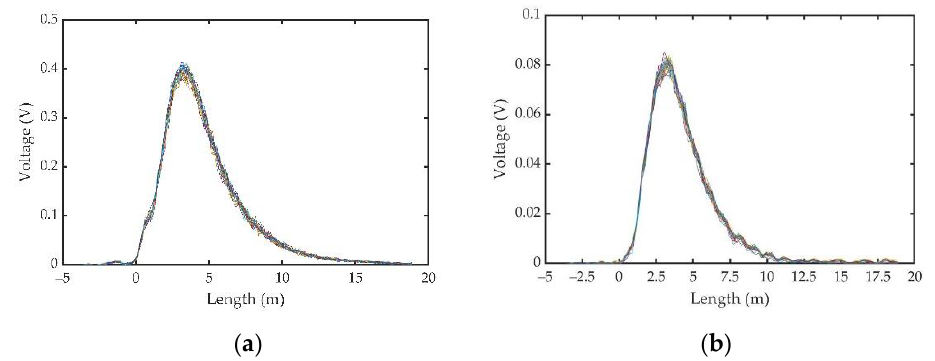
Figure 9. Scattered signals before and after passing through an iodine cell: ( a ) overall scattered signal before passing through the iodine cell; ( b ) Brillouin scattering signal after passing through the iodine cell.